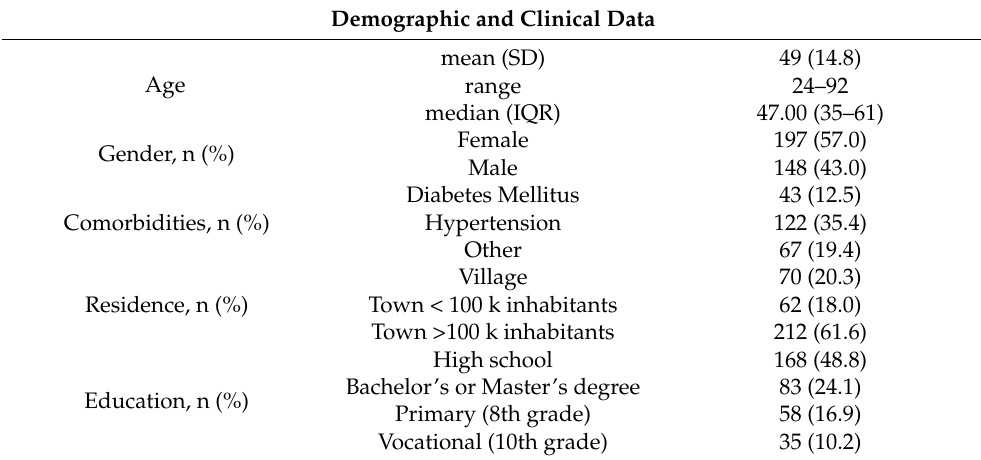
Table 3. Demographic characteristics of the GP group.